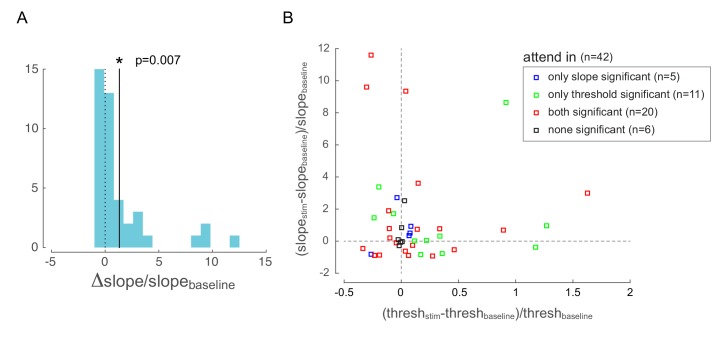
Behavioral changes with optical stimulation.(A) Change in psychometric function slope due to low-frequency optical stimulation when the monkey was attending in to the site of optical stimulation. The solid line represents the mean of the distribution, which is significantly different from zero. (B) Change in psychometric function threshold and slope due to low-frequency optical stimulation when the monkey was attending in to the site of optical stimulation. Each point represents one behavioral session. Changes are expressed as a difference between stimulation and baseline conditions (normalized by baseline). The color code represents whether the changes is threshold and slope were significant in each behavioral session: red = both threshold and slope changes were significant; green = only threshold change was significant; blue = only slope change was significant; black = neither were significant.